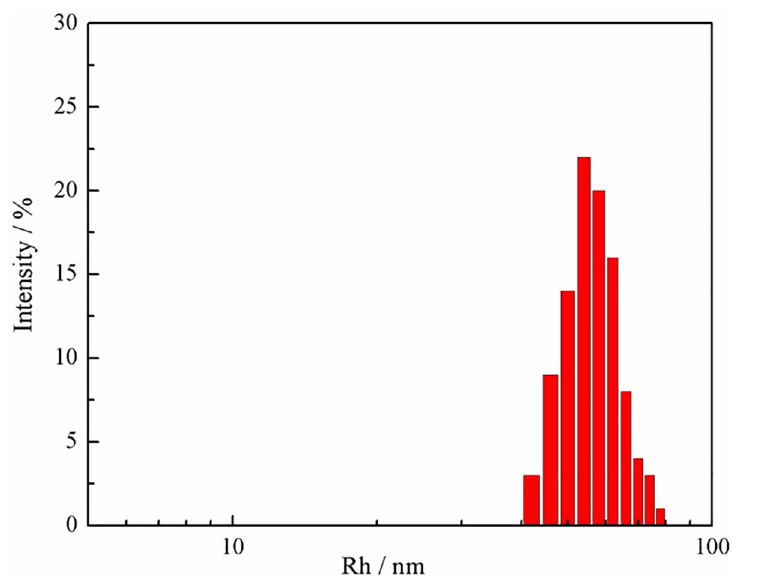
Fig 12. DLS results of nano-ZrO 2 gelatin.